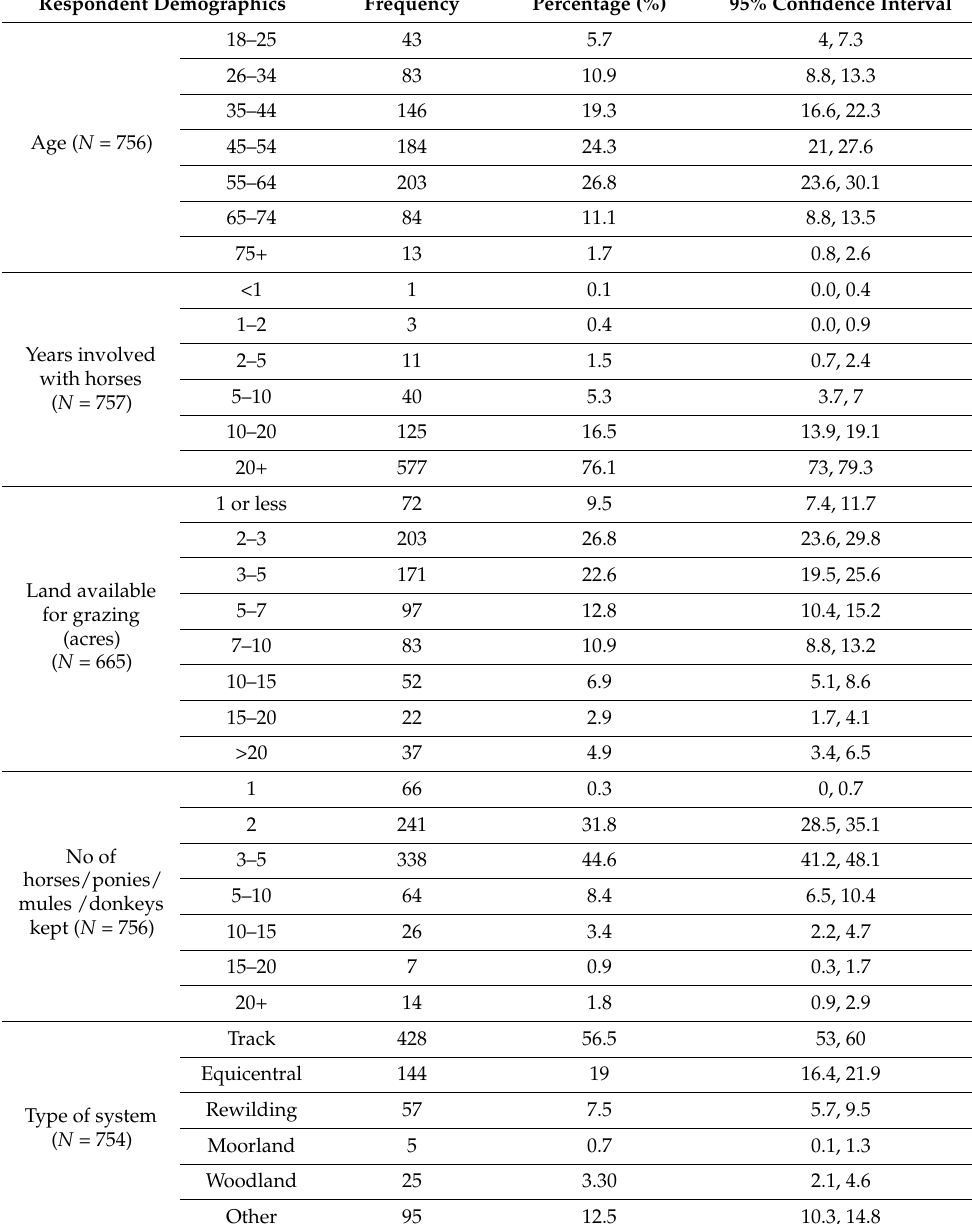
Table 1. A summary of participant age category, years of involvement with equines and grazing management system